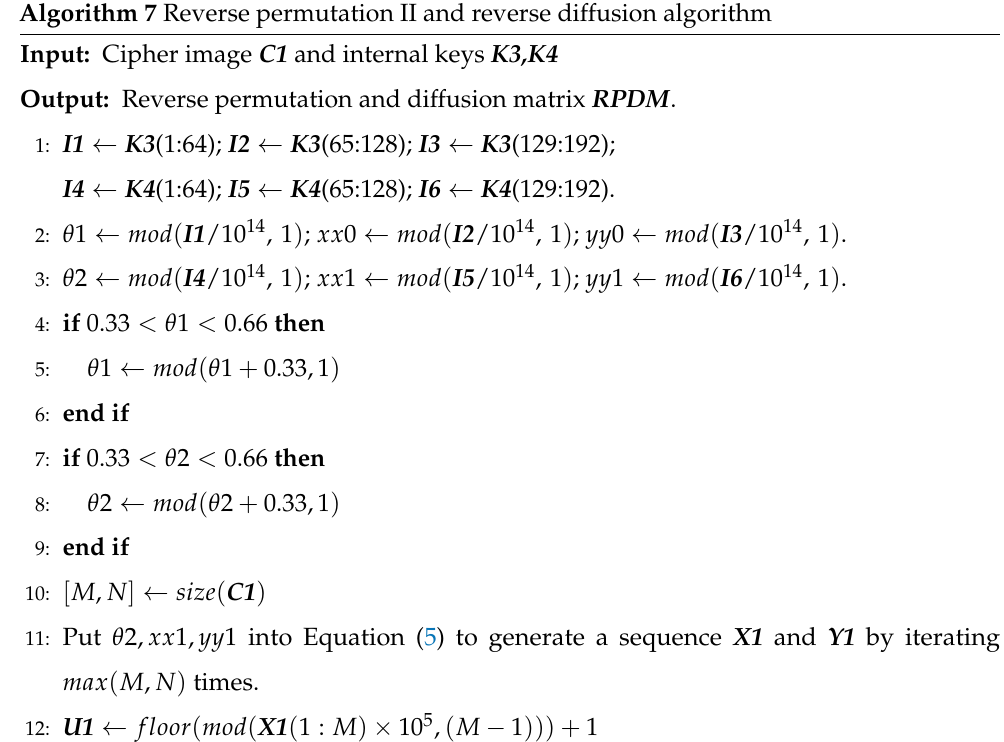
Algorithm 7 Reverse permutation II and reverse diffusion